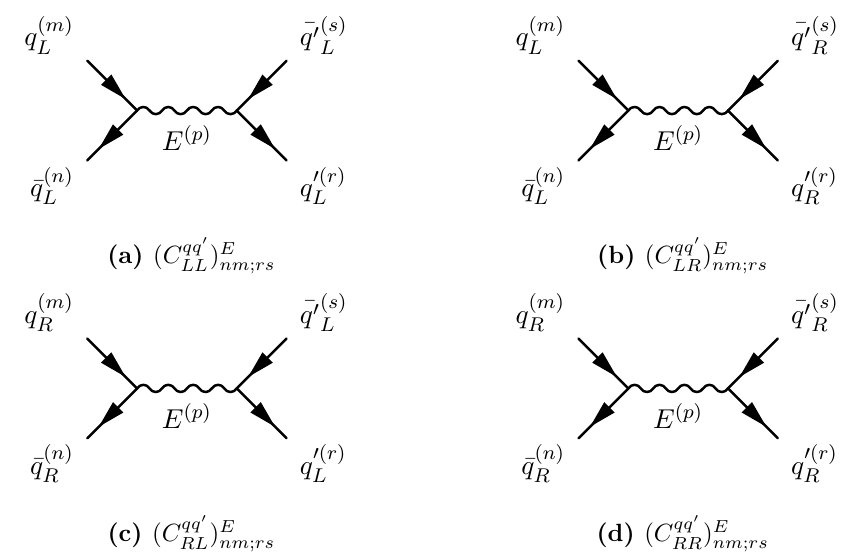
Figure 2. The Feynman diagrams that give rise to the e(cid:11)ective 4-fermion interactions discussed in eq. (6.5). Here, E ( p ) denotes the p th KK mode of any electrically neutral vector gauge